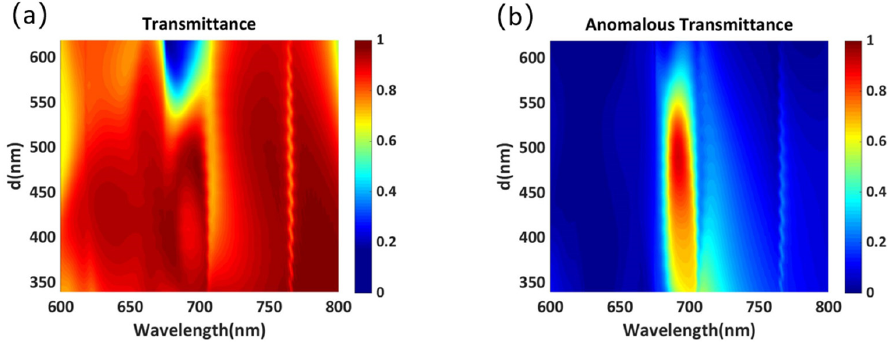
Figure 8. ( a ) Transmittance and ( b ) anomalous transmittance as a function of the element spacing d .